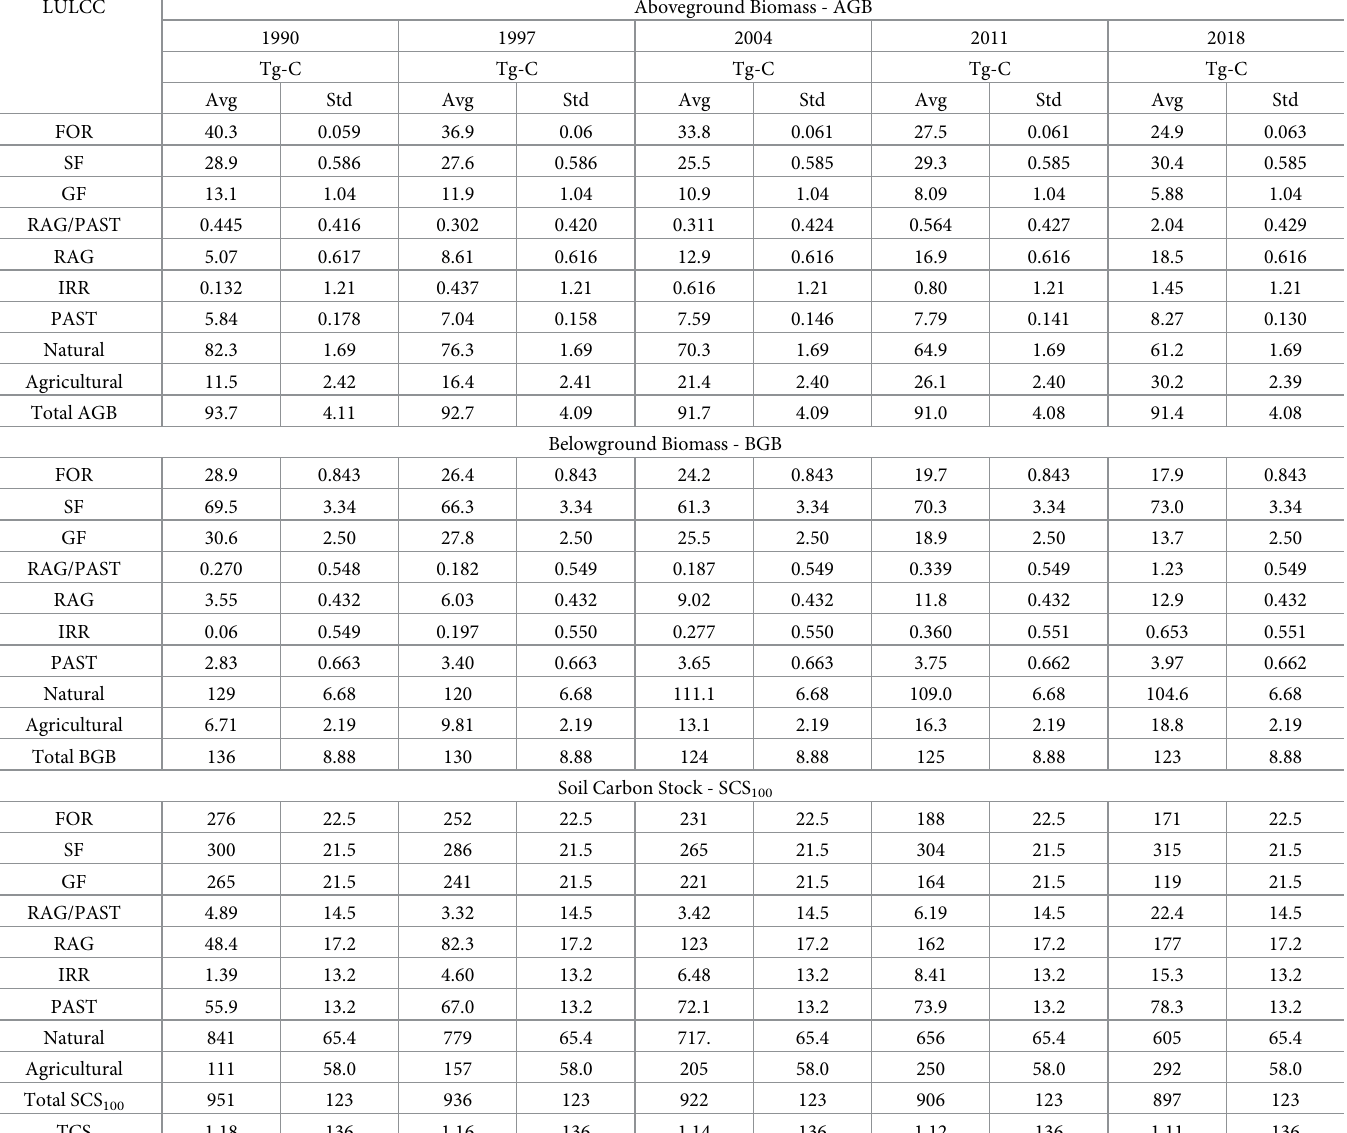
Table 6. Aboveground biomass, belowground biomass, soil C stocks and total C stocks for natural land covers (FOR, SF, GF) and agricultural land uses (RAG, IRR, PAST, RAG/PAST) in Western Bahia.